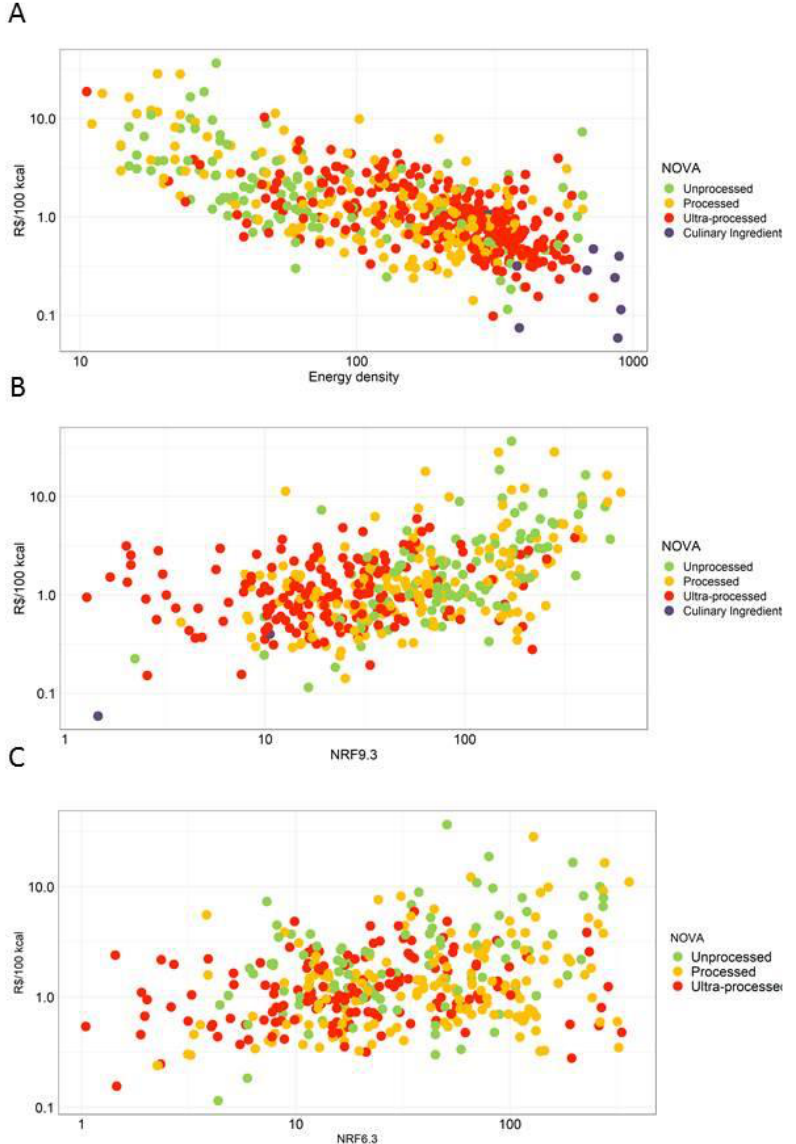
Figure 5. Price by NOVA categories and nutrient density. ( A ) Price by NOVA categories and energy density; ( B ) Price by NOVA categories and NRF9.3; ( C ) Price by NOVA categories and NRF6.3.